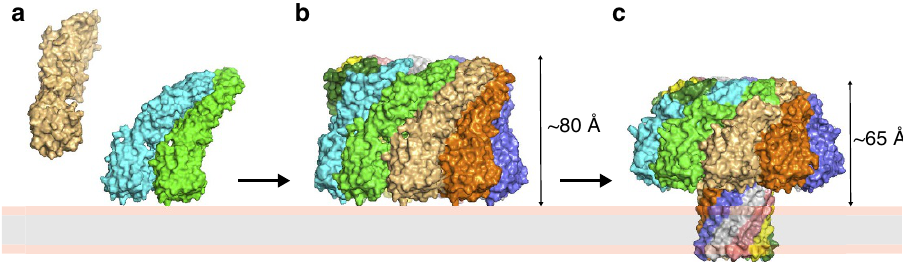
Figure 5 | Model for the mode of action by lysenin. ( a ) Lysenin monomers (PDB ID 3ZXD) will initially bind to the target cell membrane through interactions between the receptor-binding domain and POC head groups. ( b ) On membrane binding, the local concentration increase of monomers will promote oligomerization, leading to a pre-pore assembly. Depending on the orientation of the monomers, the height of the pre-pore may be as high as 100Å (the length of a lysenin monomer). ( c ) The membrane-inserted form of lysenin solved in this study will extend B 65Å above the membrane surface. The hypothetical pre-pore shown here was assembled by imposing ninefold symmetry to the monomeric crystal structure aligned in reference to the receptor-binding domain of the membrane-inserted